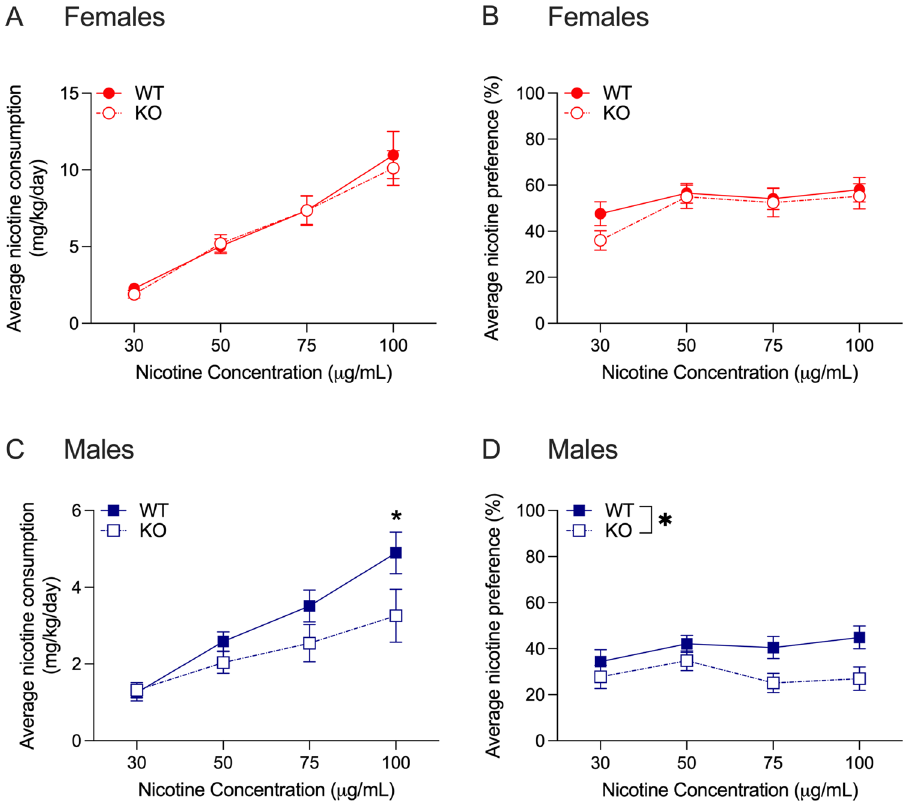
Figure 2. Nicotine consumption and preference in Hgfac WT and KO mice. Female Hgfac WT and KO mice showed no significant differences in ( A ) nicotine consumption or ( B ) preference. ( C ) Male Hgfac KO mice consumed less nicotine at the 100 μg/mL concentration compared with WT littermates. Sidak’s multiple comparisons testing * P < 0.05 between WT and KO mice. ( D ) Male Hgfac KO mice consumed less nicotine overall compared with WT mice. * P = 0.04 for main effect of genotype. Data are presented as mean ± SEM, n = 17–18 female mice per genotype, n = 16–19 male mice per